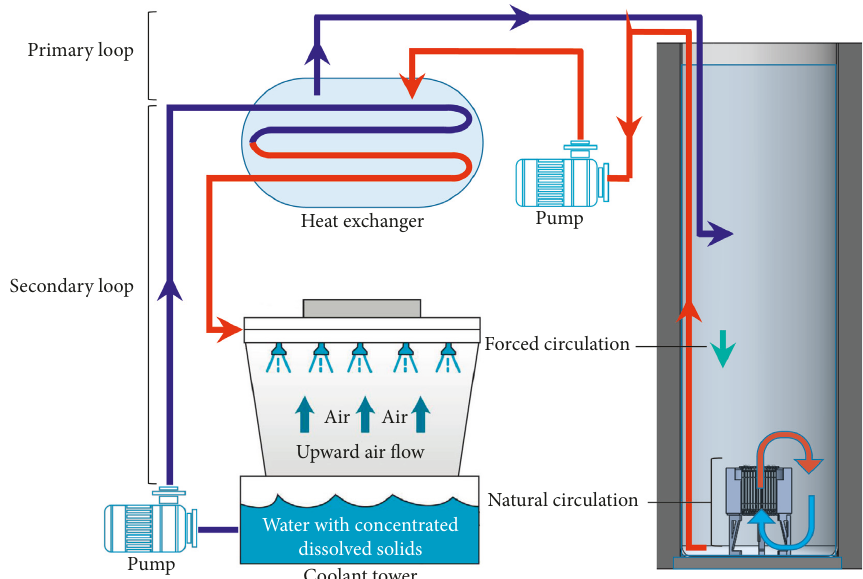
Figure 3: Schematic representation of the GSTR coolant circuit.